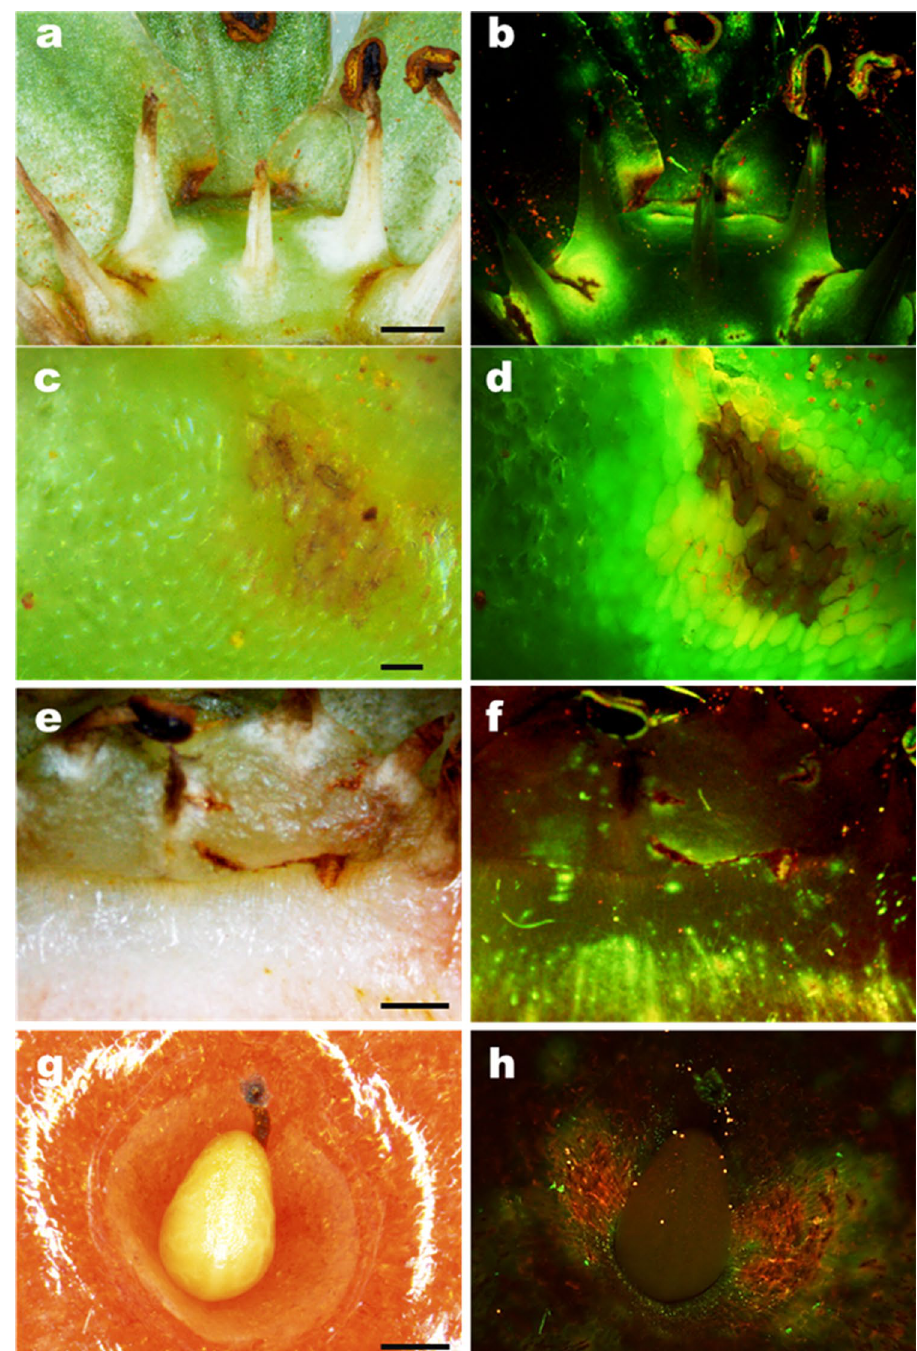
Figure 6. Micrographs of microcracks in the cuticle on the surface of ripe strawberries cv. Clery after incubation in the fluorescent tracer acridine orange. Images were taken in incident bright light ( a, c, e, g ) and incident fluorescent light ( b, d, f, h ). a, b microcracks at the base of stamina and the abscission zone of petals; c, d detailed view of microcrack at the base of a stamen; e, f microcracks at the calyx-receptacle junction and in the seedless zone of the receptacle; g, h microcracks in the depression of an achene on the surface of strawberry fruit. Scale in a,e = 1 mm, c = 0.1 mm and g = 0.5